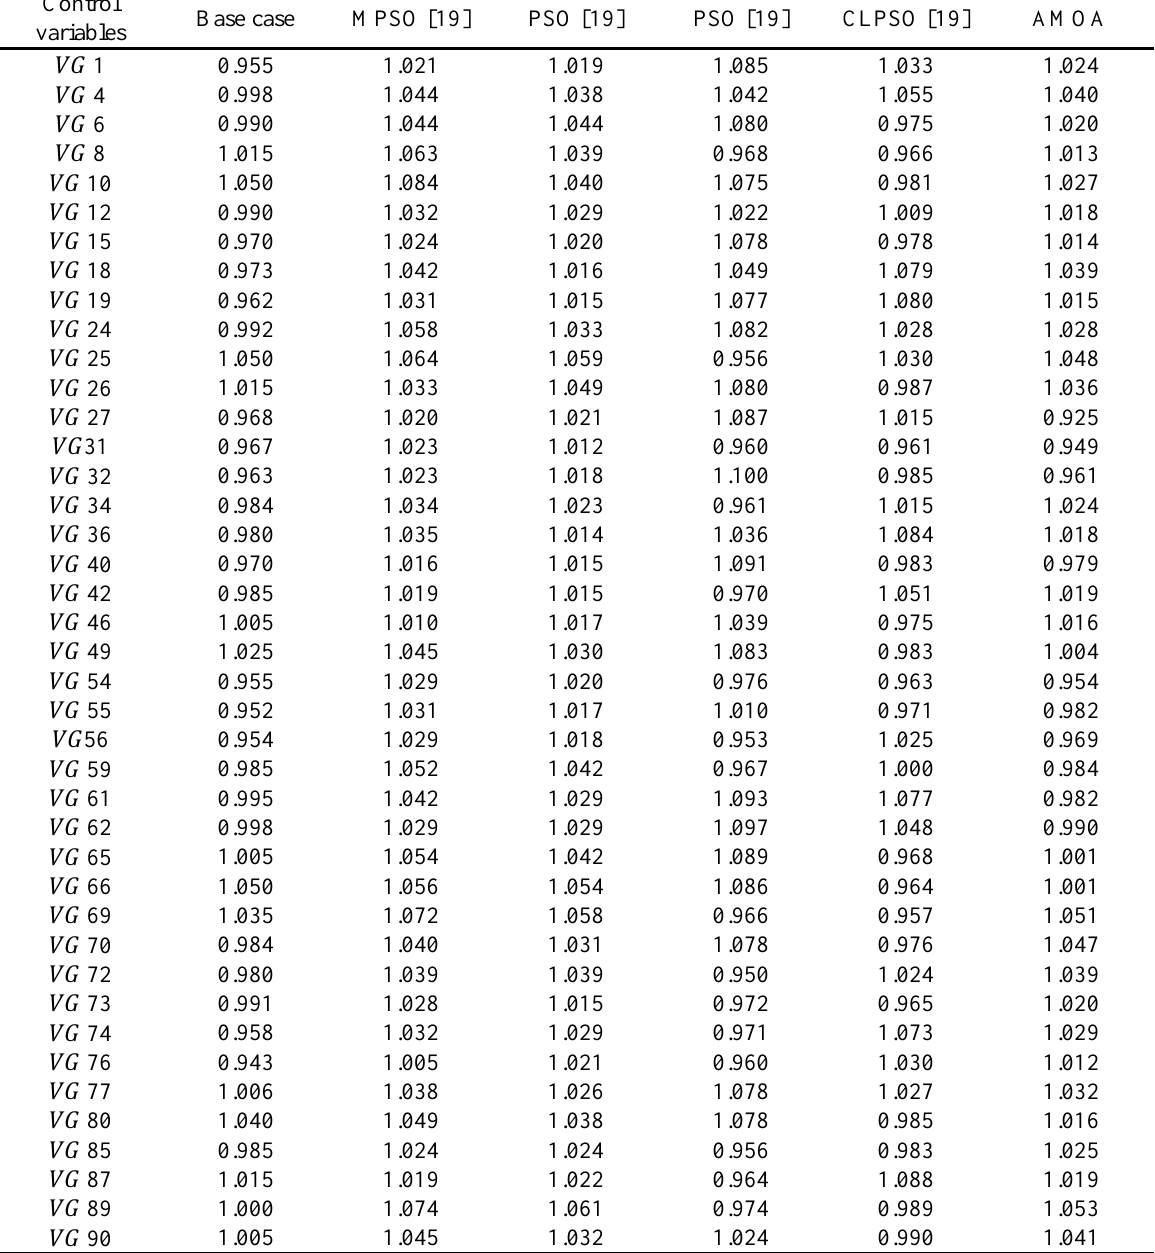
Table 11. Simulation results of IEEE −118